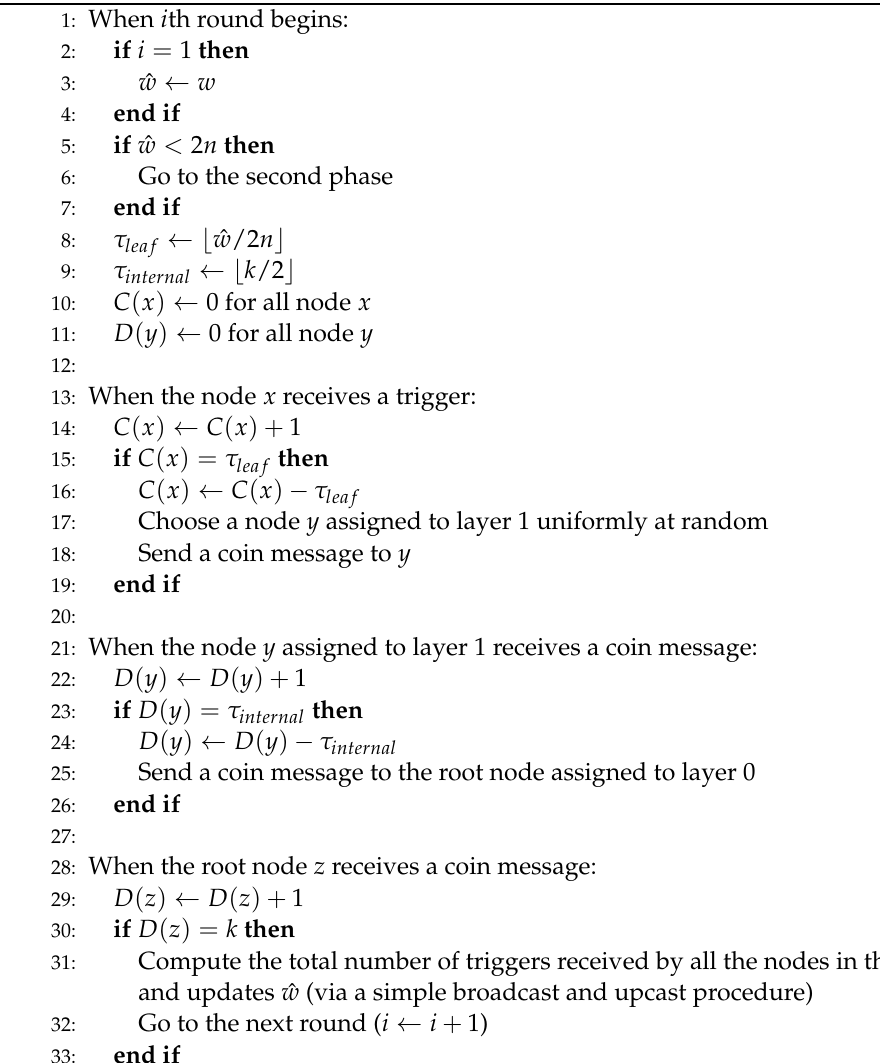
Algorithm 1: The first phase of the proposed